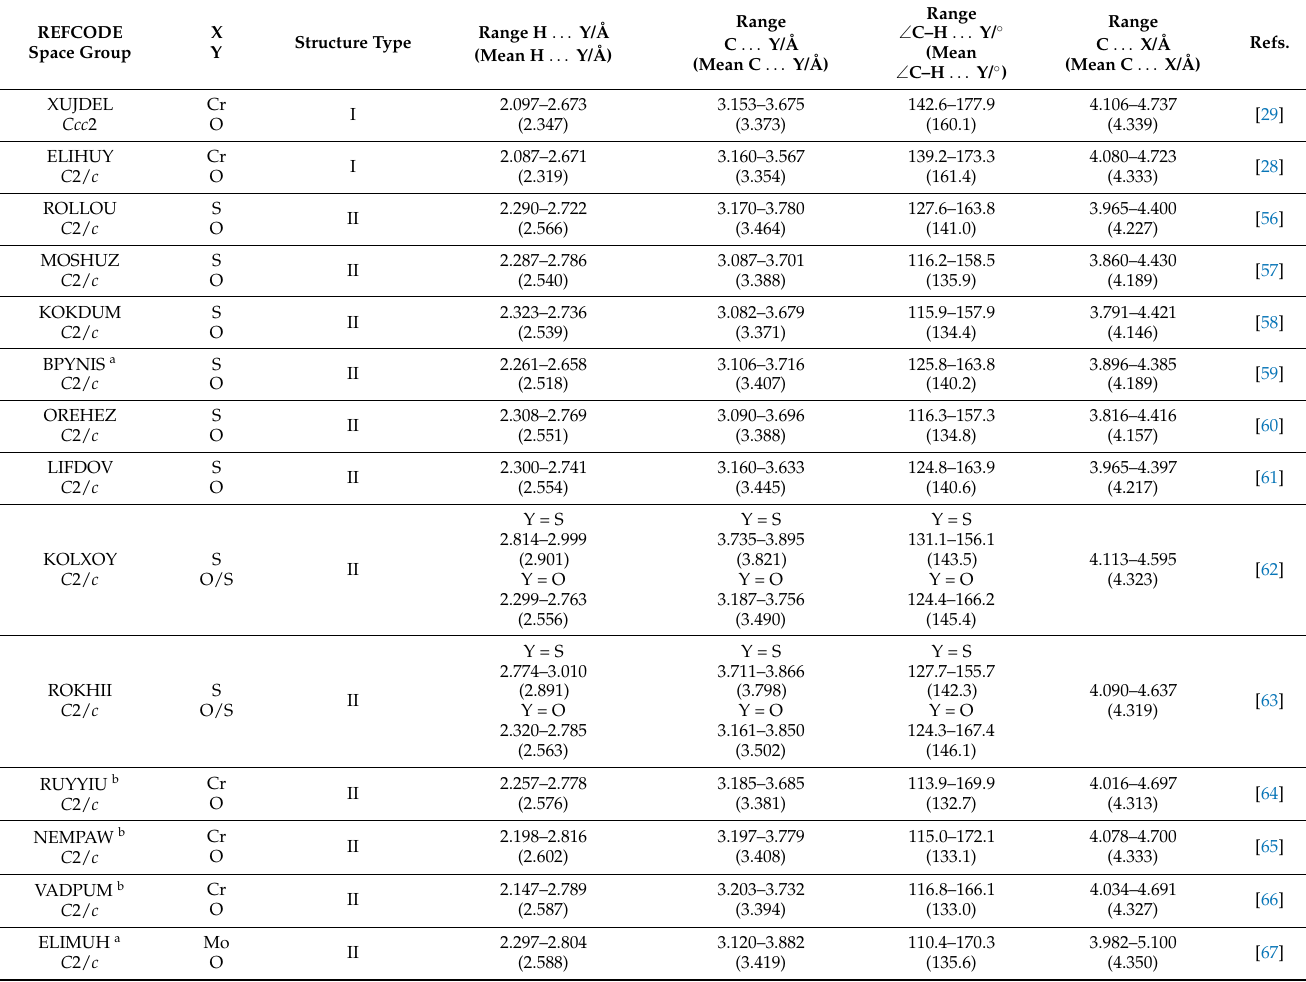
Table 3. Structure Type I and II complexes with [XY 4 ] m – anions.